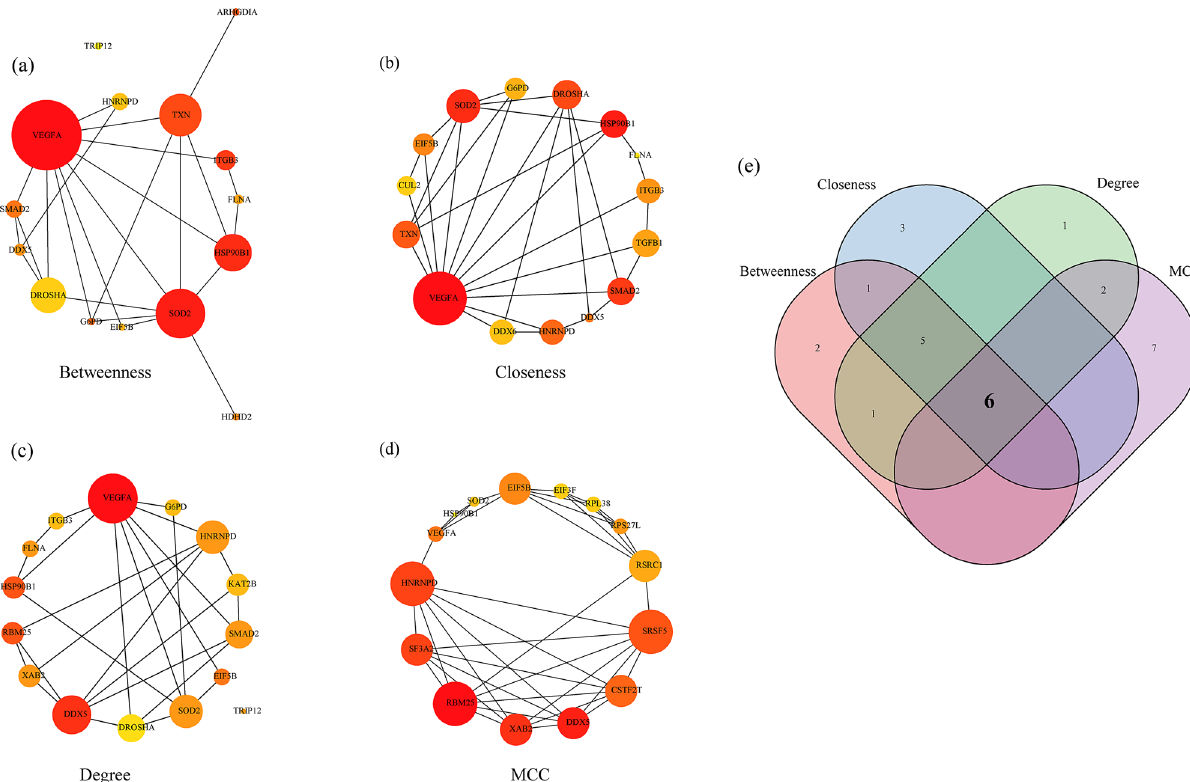
Figure 8: Identi fi cation of Hub genes: ( a ) PPI network of hub genes obtained by Betweenness algorithm, ( b ) PPI network of hub genes obtained by Closeness algorithm, ( c ) PPI network of hub genes obtained by Degree algorithm, ( d ) PPI network of hub genes obtained by MCC algorithm, and ( e ) Venn diagram of the Hub genes obtained by the four